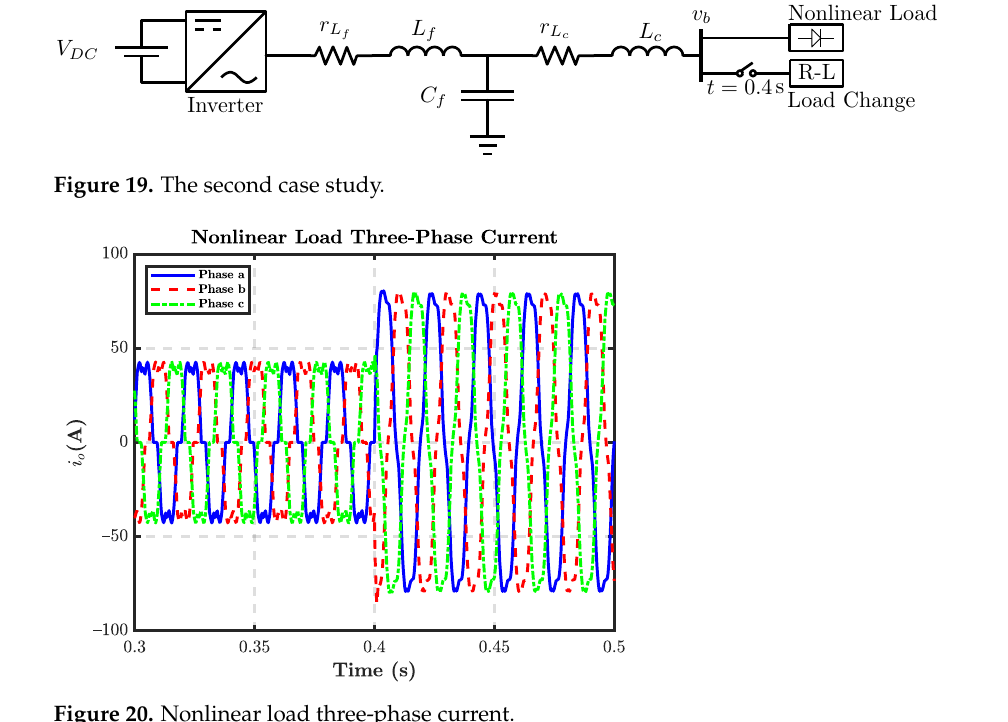
Figure 20. Nonlinear load three-phase current.